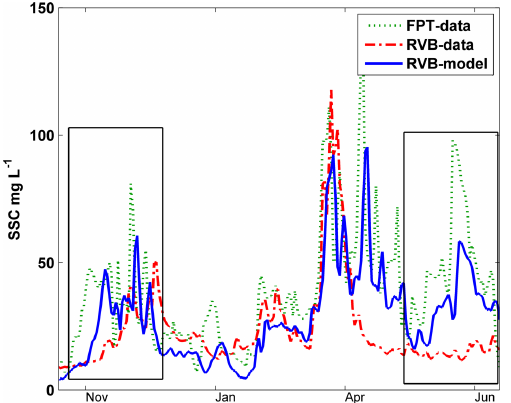
Figure B1. Comparison between SSC levels in RVB station in situ data (dashed red) and model result (solid blue) and FPT station (dot- ted green).